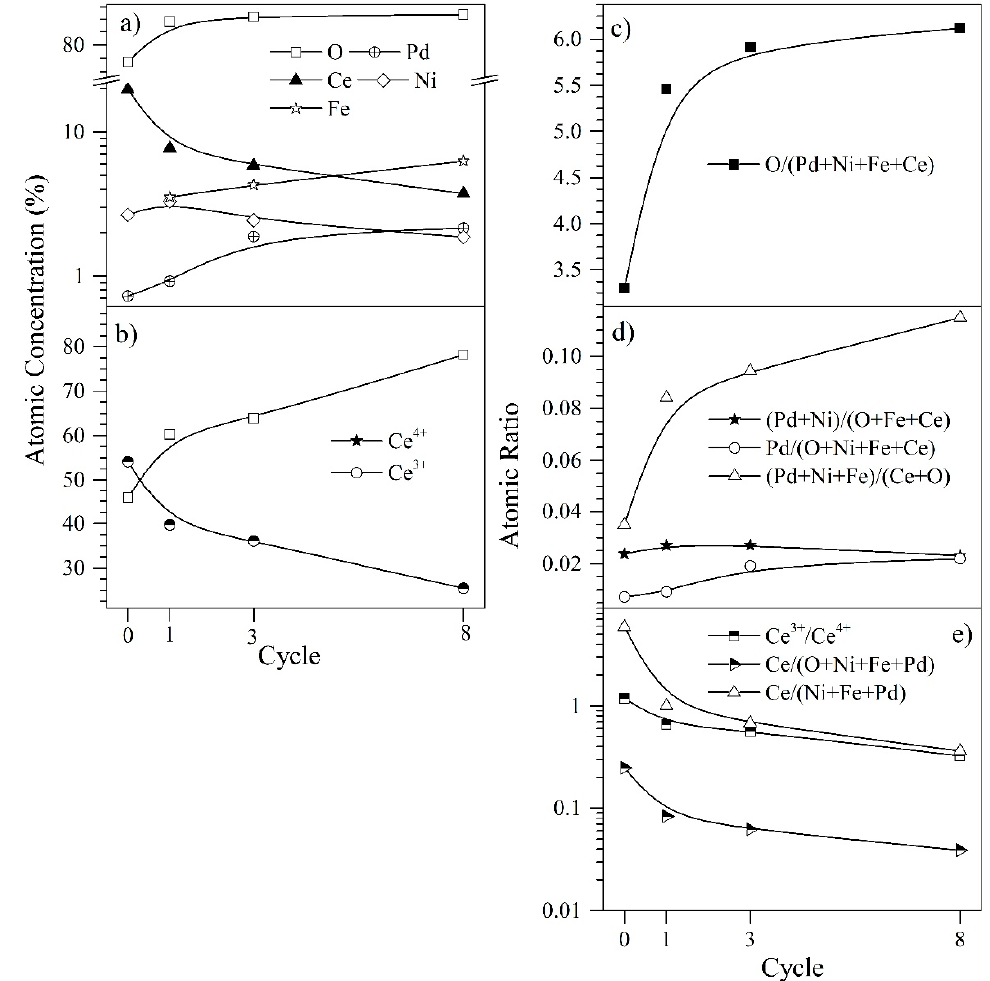
Figure 10. Surface atomic concentration and ratios of the different analyzed elements through XPS of the CeNi0.89Pd1.1 nanoparticles in the n -C 7 asphaltene adsorption/decomposition in catalytic steam gasification for the regeneration cycles 1, 2, 4 and 9. ( a ) Atomic concentration of the all analyzed elements, ( b ) atomic Ce 3+ and Ce 4+ concentrations, ( c–d ) atomic ratios and ( e ) cerium ratios and concentrations according to oxidation state.